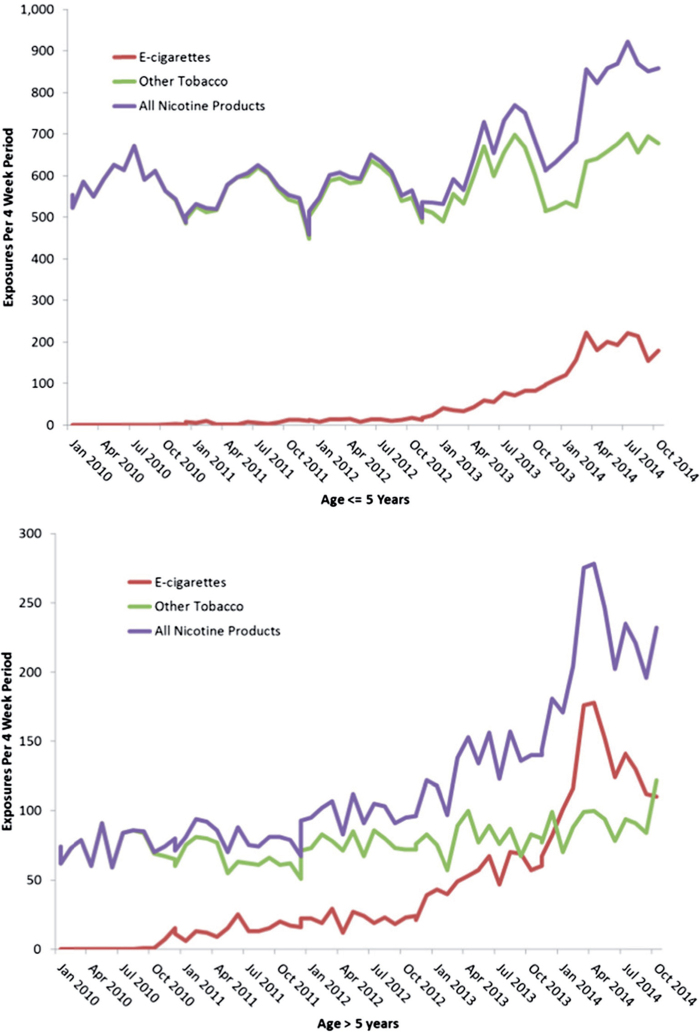

E-cigarette product exposures, January 2010–October 2014. The figures show the number of calls received per 4-week period by age group for single-substance human poison exposure calls to an e-cigarette device or refill ( E-cigarette), traditional tobacco products such as cigarettes, snuff, and chewing tobacco ( Other Tobacco) and the sum of the two groups ( All Nicotine Products) since January 2010. Pharmaceutical nicotine products are excluded (colour version of this figure can be found in the online version at www.informahealthcare.com/ctx).